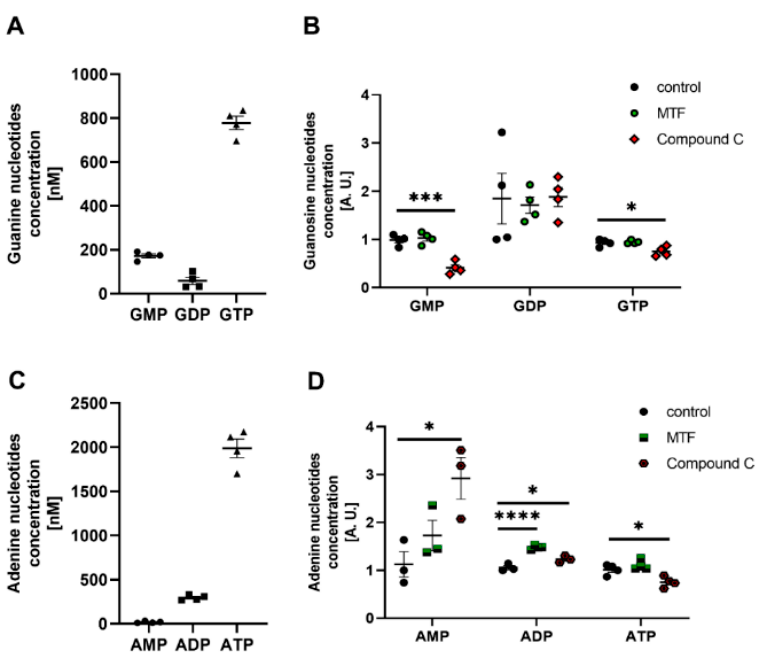
Figure 6. Effect of AMPK modulators on the energy state of podocytes. ( A , C ) Guanine ( A ) and adenine ( C ) nucleotide levels in cultured rat podocytes; ( B , D ) Effect of MTF (AMPK activator, 2 mM, 2 h) and compound C (AMPK inhibitor, 100 µ M, 2 h) on concentrations of guanine ( B ) and adenine ( D ) nucleotides in cultured podocytes. The data were analyzed using Dunnett’s test and are expressed as the mean ± SEM. n = 3–4. * p < 0.05, *** p < 0.001, **** p < 0.0001, compared with appropriate control.